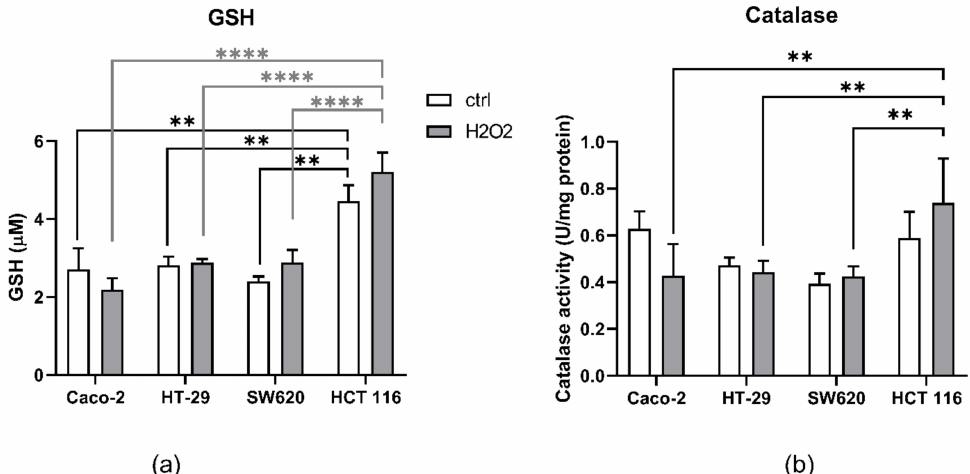
Figure 2. Antioxidant status of Caco-2, HT-29, SW620, and HCT 116 after 100 µ M H 2 O 2 challenge: ( a ) total GSH levels before and after H 2 O 2 challenge in all four cell lines; ( b ) catalase activity before and after H 2 O 2 challenge in all four cell lines. The results present the mean ± SD from three independent experiments. Significance levels: ** p < 0.01 and **** p <